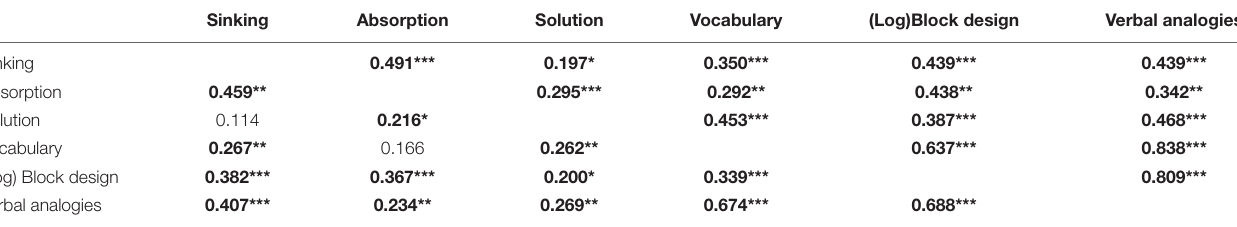
TABLE 2 | Zero-order (above diagonal) and partial correlations (below diagonal) between causal measures and cognitive ability measures (significant associations in bold).